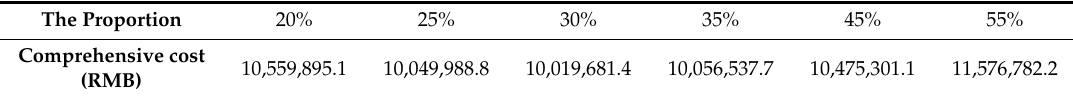
Table 3. Optimization results of uncertain sets.